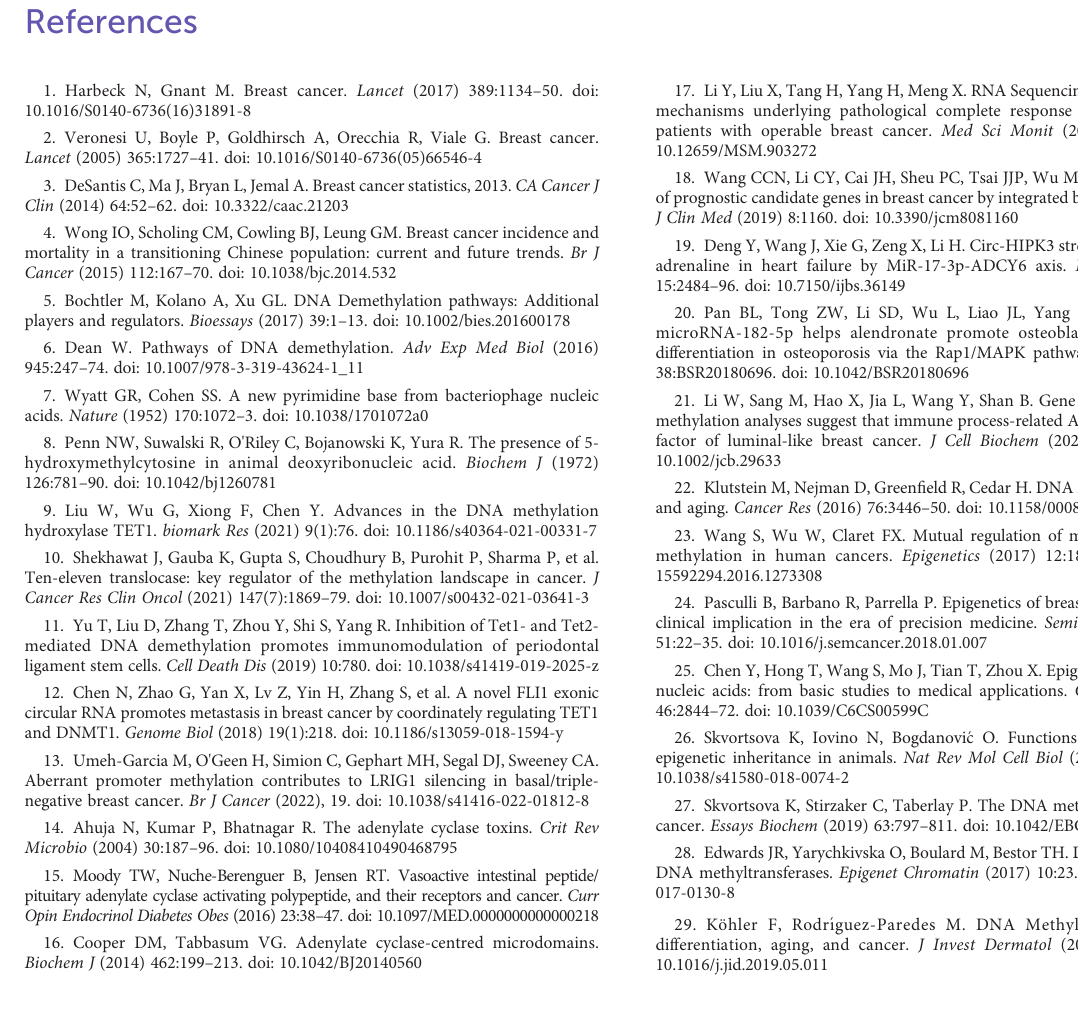
67 in MDA-MB-231-De-miR-27a-3p cells after decreased the expression of ADCY6 was detected by immunohistochemistry. Scale bars, 25 µm. (B) The protein expression of ADCY6 and EMT components, including E- cadherin, N-cadherin, vimentin, twist1 and Ki-67 in MCF-7-De-miR-27a- 3p cells after decreased the expression of ADCY6 was detected by immunohistochemistry. Scale bars, 25 µm. SUPPLEMENTARY FIGURE 5 Effect of reducing the expression of miR-27a-3p on EMT. (A) Protein expression of EMT components, including: E-cadherin, N-cadherin, vimentin, twist1 and Ki-67 in MDA-MB-231cells. *p < 0.05 versus controls. (D) Protein expression of EMT components, including: E- cadherin, N-cadherin, vimentin, twist1 and Ki-67 in MCF-7 cells. *p < 0.05 versus controls. SUPPLEMENTARY FIGURE 6 Effect of reducing the expression of TET1 on EMT in MDA-MB-231-De- miR-27a-3p and MCF-7-De-miR-27a-3p cells. (A) Protein expression of TET1, ADCY6 and EMT components, including: E-cadherin, N-cadherin, vimentin, twist1 and Ki-67 in MDA-MB-231-De-miR-27a-3p cells after decreased the expression of TET1. *p < 0.05 versus controls. (D) Protein expression of TET1, ADCY6 and EMT components, including: E-cadherin, N-cadherin, vimentin, twist1 and Ki-67 in MCF-7-De-miR-27a-3p cells after decreased the expression of TET1. *p < 0.05 versus